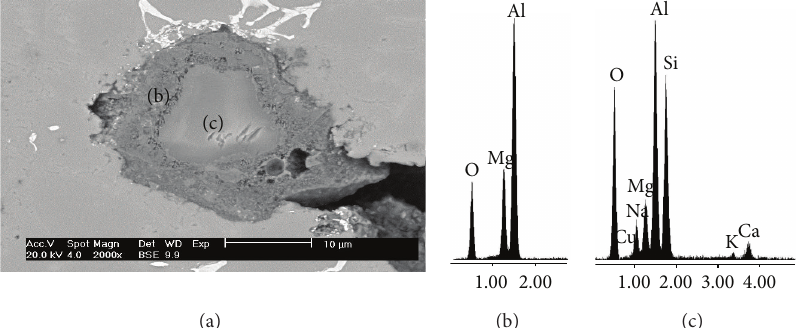
Figure 7: (a) Image of backscattered electron for a semireacted particle of enriched zeolite with 5% of SiO 2 nanoparticles, obtained after 20 minutes of injection; EDX of (b) shell and (c) center of